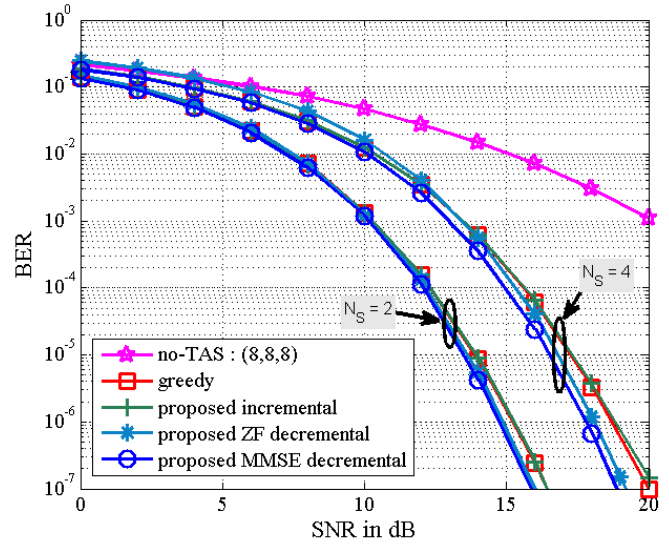
Figure 4. BER the proposed TAS selection algorithms for ( 8, N S , K ) MU–STLC system with N S = K.